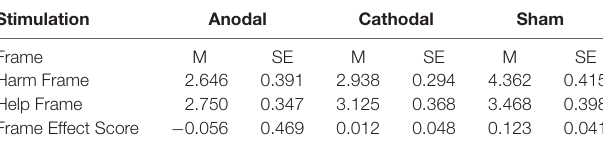
TABLE 2 | Means (M) and standard error (SE) of the data for the social framing effects under three conditions. Stimulation